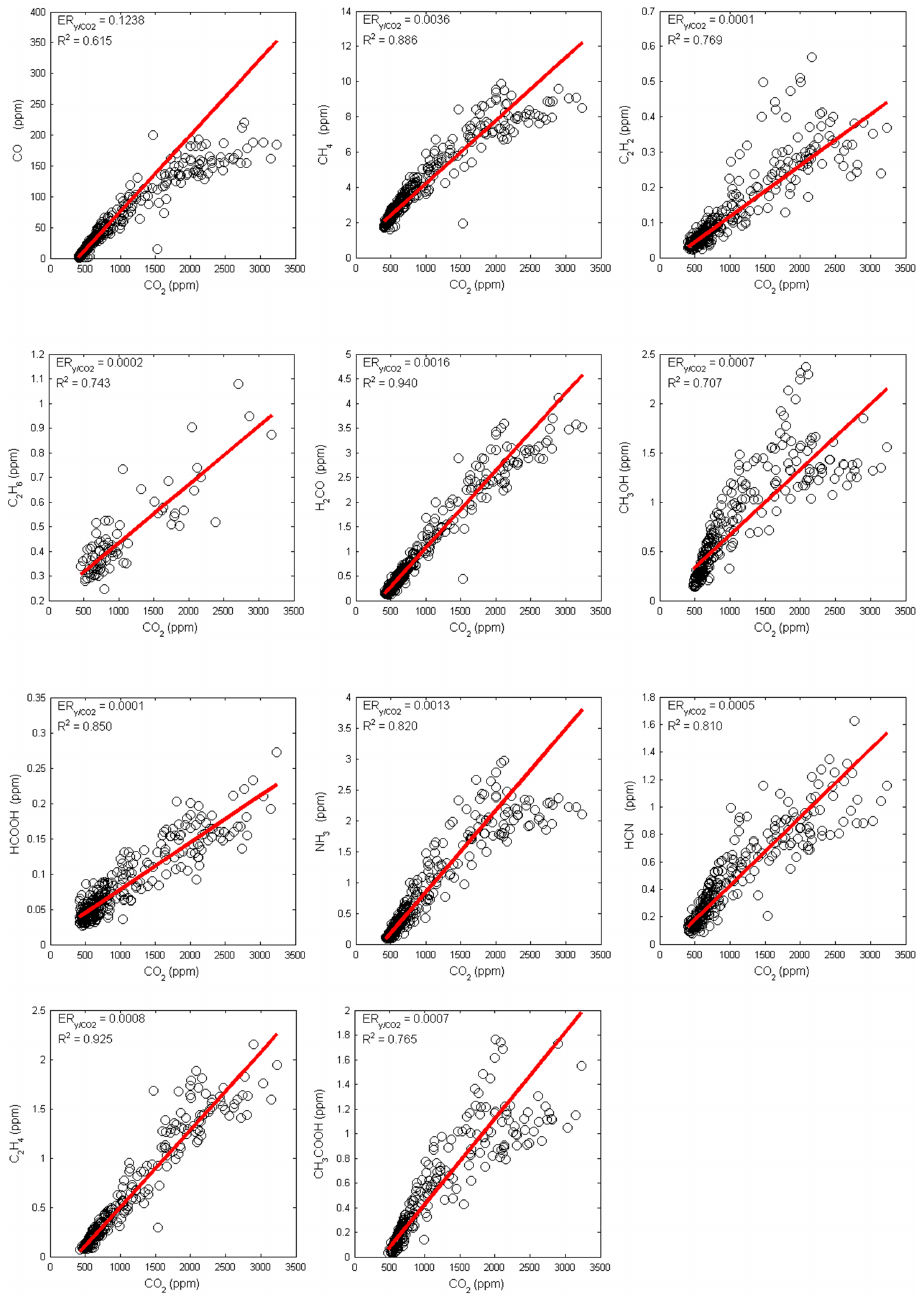
Figure 8. Example scatter plots of the measured trace gas path-length-averaged mole fractions used to calculate emission ratios. The data presented here are from LD-TGOW-A (30 September 2009). The slope of the least squares linear best fit to these data (thick red line) is used ) . For each of the 10 trace gases shown above, the emission ratio and the R 2 is given towards to derive the relevant emission ratio (ER x / CO 2 the top of each plot. The equivalent plots for emission ratios to CO are presented in Fig.